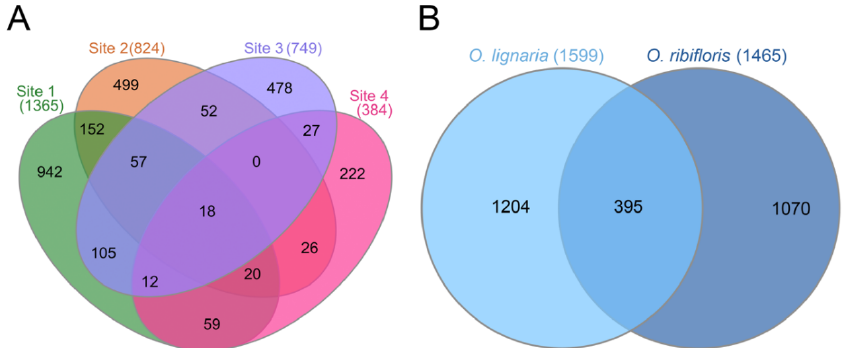
Figure 4. Venn diagrams of Amplicon Sequence Variants (ASVs) in greater than 0.01% overall abundance found in ( A ) sampling locations between all species with color denoting site and ( B ) ASVs in greater than 0.01% overall abundance found in species between all sampling locations with color denoting species. Numbers in both panels denote number of ASVs present in each location / species or the union between multiple categories.